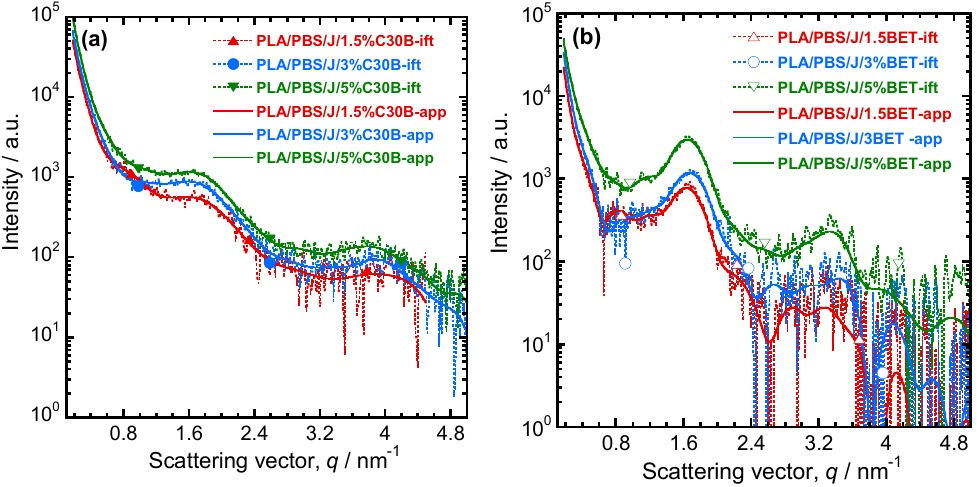
Figure 7. Background (scattering pattern of the PLA/PBS/J blend) subtracted scattering profiles of ( a ) PLA/PBS/J/C30B and ( b ) PLA/PBS/J/BET for different clay loadings. “ift” stands for the experimental scattering curve after background subtraction and “app” stands for the approximate scattering curves determined on the basis of GIFT analysis. BET is Betsopa™, C30B is Cloisite ® 30B, and J is Joncryl.